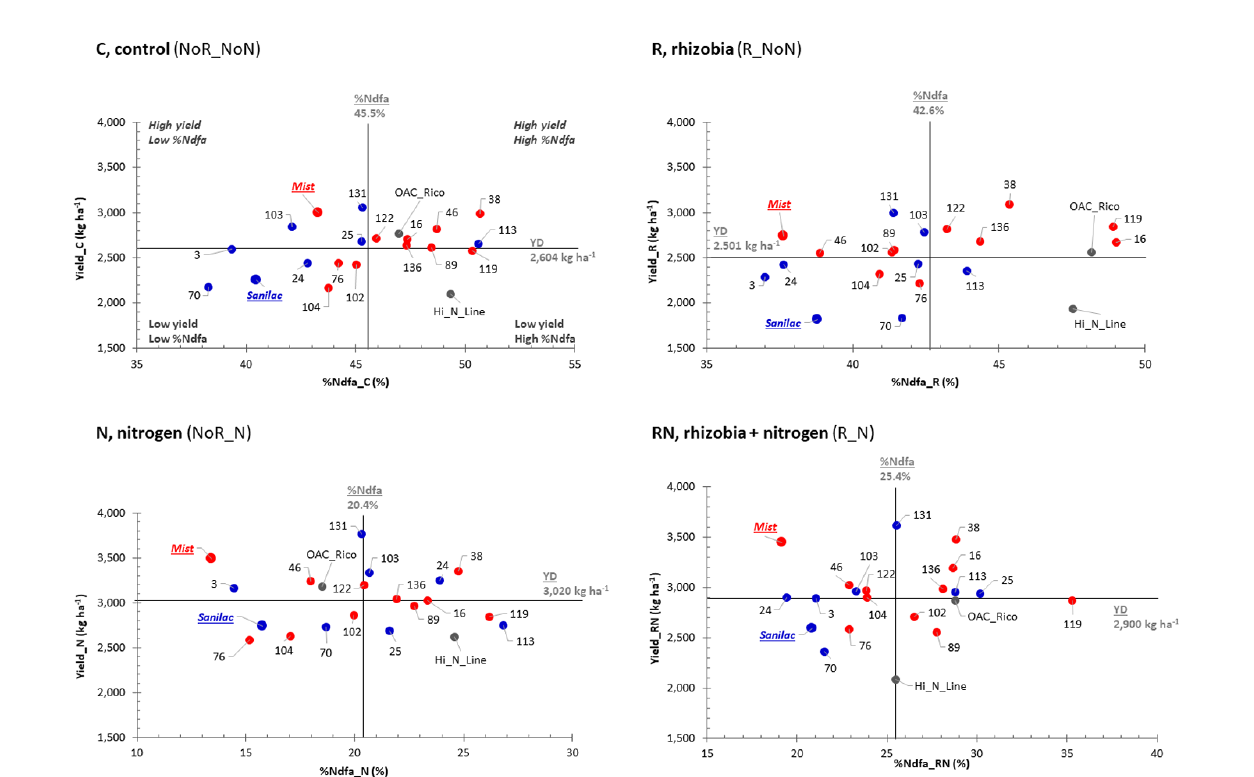
FIGURE 4 | Selection of high-yielding common bean genotypes having a high percentage of nitrogen derived from atmosphere (%Ndfa) in combined 2017-2018 experiments. Yield and %Ndfa plots of 22 bean genotypes in four nitrogen/rhizobia treatments [control (C treatment, NoR_NoN), nitrogen (N treatment, NoR_N), rhizobia (R treatment, R_NoN) and combined application of nitrogen fertilizer and rhizobia inoculation (RN treatment, R_N)] evaluated at the Elora research station, ON in combined 2017_2018 experiment. Plots are divided into four quadrants based on the yield and %Ndfa mean values (black lines): the best performing genotypes are at the top right quadrant [they are both high yielding and good nitrogen fi xers )%Ndfa); genotypes at the top left quadrant are high yielding but low nitrogen fi xers; genotypes at the bottom left quadrant are low yielding and low nitrogen fi xers; and genotypes at the bottom right quadrant are low yielding but have good nitrogen fi xing abilities. Genotypes: Mist (red, italic), SNF parent (high yield under SNF condition) and 10 SNF-dependent (high yield under SNF condition) RILs (red) and Sanilac (blue, italic), N parent (high yield under nitrogen fertilizer) and seven N-dependent (high yield under nitrogen fertilizer) RILs